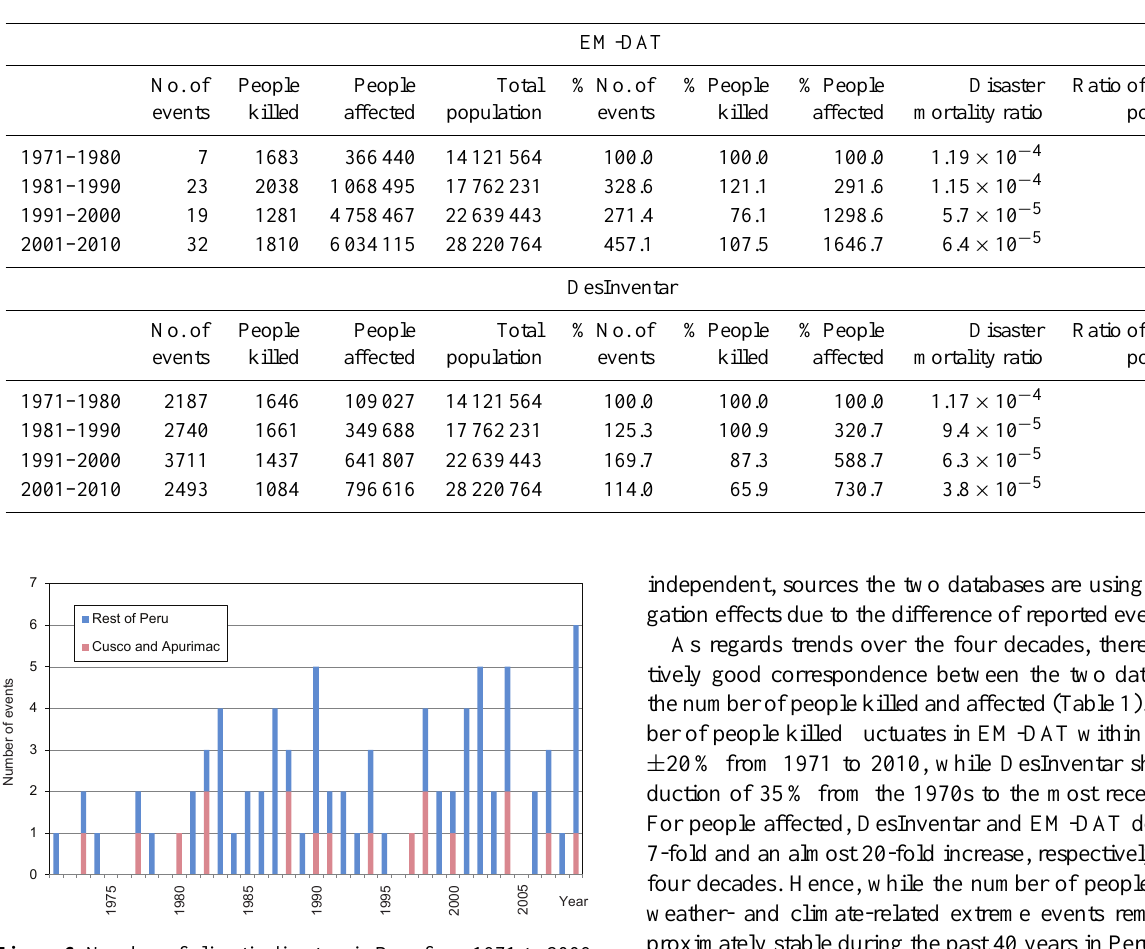
Table 1. A comparison of metrics of weather- and climate-related disasters in Peru in the EM-DAT and DesInventar databases. The percent- ages refer to the reference state of the first decade (1970s). Information on total population is derived from census from individual years (1972, 1981, 1993, 2007). Sources: CRED (2013), DesInventar (2013) and Peruvian National Institute of Statistics and Informatics (INEI).